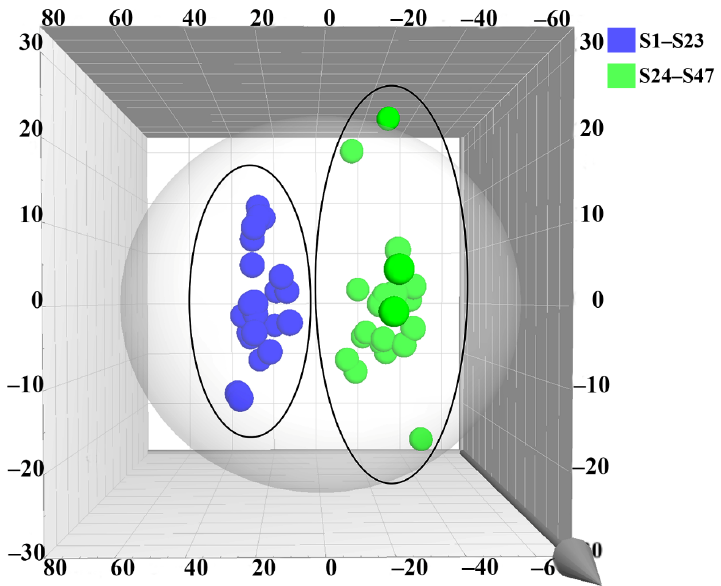
Figure 4. The OPLS-DA model for the classification of ES and WS is based on the content of 60 constituents.